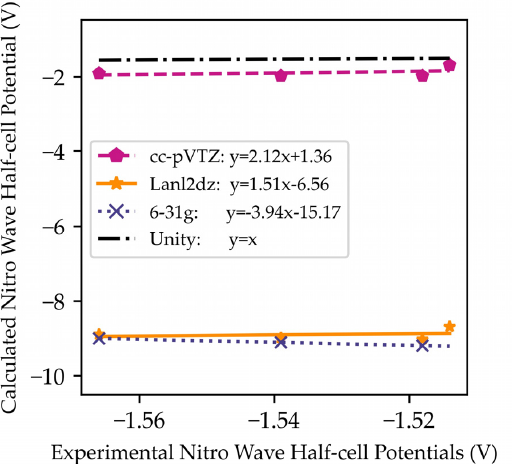
Figure 7. Comparison of computational electrochemical cell potentials vs. experimental [33] electro- chemical cell potentials for the nitro wave for the nitro group containing derivatives (E1-E4). The B3LYP/cc-pVTZ method is indicated by pink pentagons and the previously calculated methods B3LYP/lanl2dz and B3LYP/6-31G [27] are indicated with blue crosses and yellow stars, respectively.